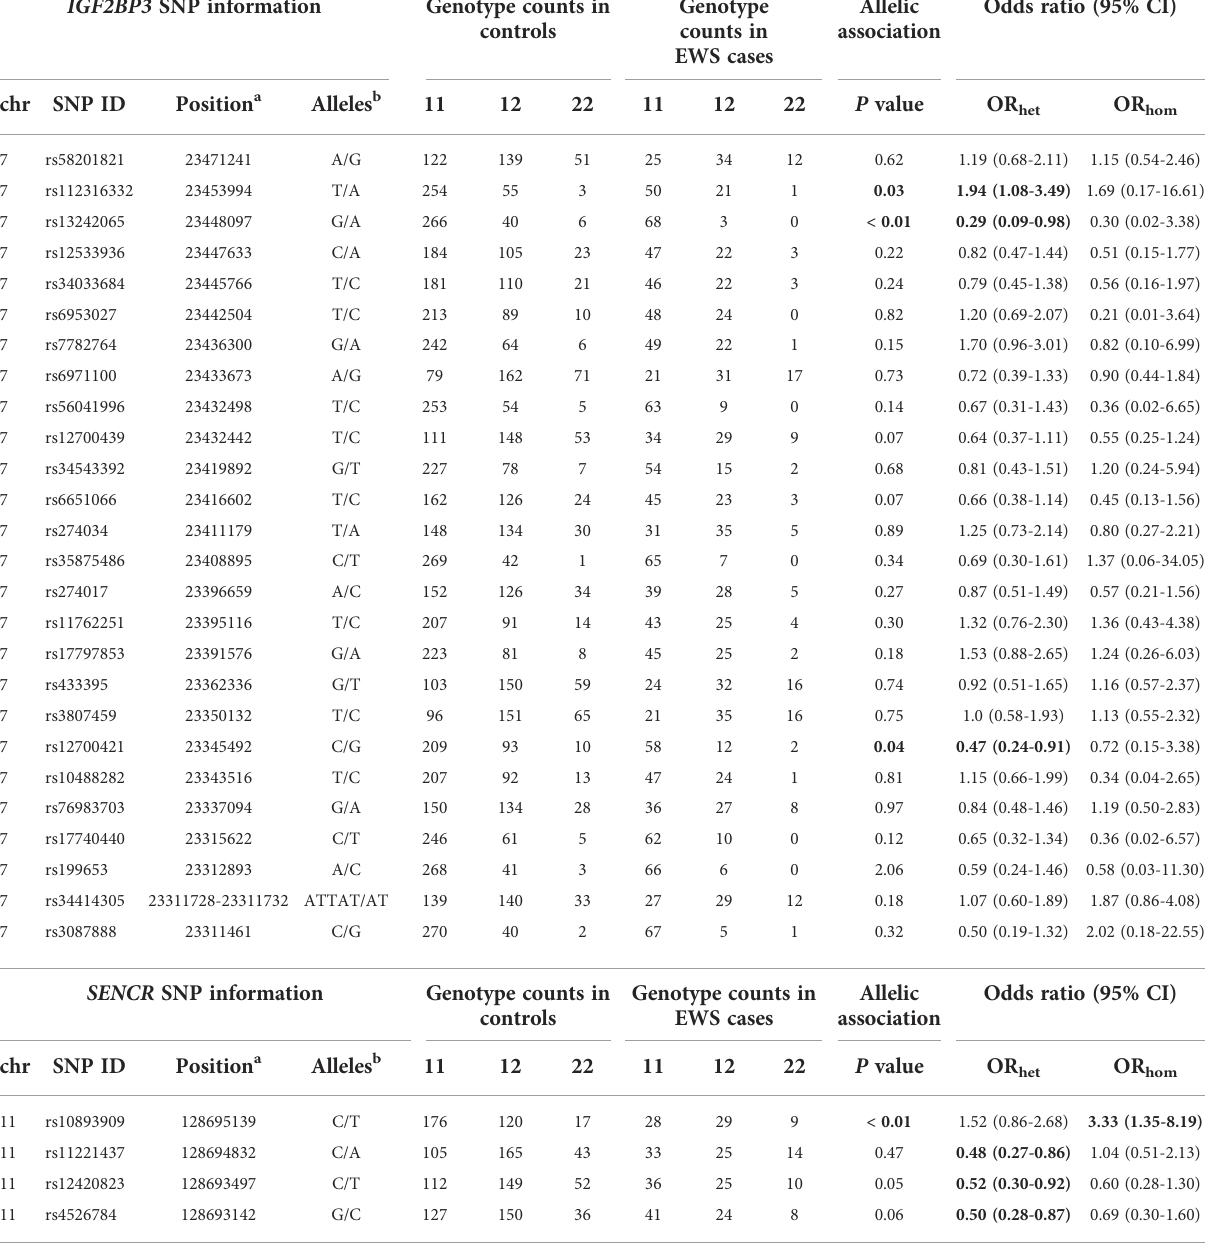
a UCSC Genome Browser assembly ID: hg38. b Major allele is provided fi rst. chr, chromosome; SNP ID, single nucleotide polymorphism code at NCBI dbSNP; MAF, minor allele frequency; CI, con fi dence interval, OR het , odds ratio for heterozygote; OR hom , odds ratio for homozygote. Bold type indicates signi fi cant association level ( P <